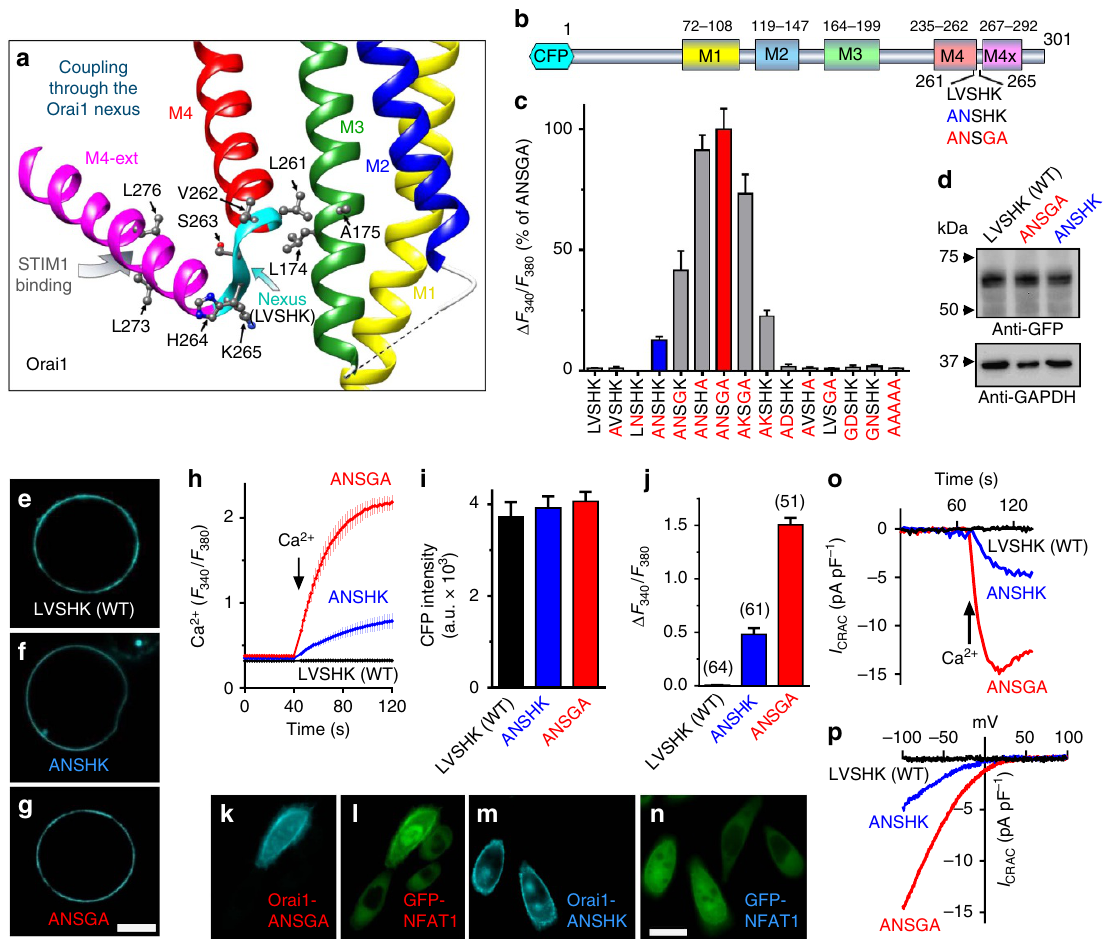
Figure 1 | The Orai1-ANSGA nexus mutation mediates constitutive store-independent CRAC channel activity. ( a ) Schematic representation of the human Orai1 nexus (LVSHK; 261–265) and surrounding helices (Supplementary Fig. 1). ( b ) Diagram of hOrai1 transmembrane -helices and nexus mutations. ( c ) Peak constitutive Ca 2 þ entry mediated by CFP-Orai1 nexus mutations expressed in HEK cells, compared with the effect of ANSGA (100%). ( d ) Expression of CFP-Orai1-LVSHK (WT), CFP-Orai1-ANSGA and CFP-Orai1-ANSHK detected with GFP antibody, compared with GAPDH expression. ( e – g ) PM localization of CFP-Orai1-LVSHK (WT), CFP-Orai1-ANSHK and CFP-Orai1-ANSGA in HEK cells. Scale bar, 5 m m ( h ) Fura-2 ratiometric constitutive Ca 2 þ responses in HEK cells expressing CFP-Orai1-LVSHK (WT), CFP-Orai1-ANSHK or CFP-Orai1-ANSGA. ( i ) CFP fluorescence intensity (a.u.) of cells in h . ( j ) Average peak Ca 2 þ entry responses from three independent experiments. ( k – n ) Nuclear translocation of NFAT-GFP ( l , n ) induced by CFP-Orai1- ANSGA ( k , l ) or CFP-Orai1-ANSHK ( m , n ) transfected into Hela cells stably expressing NFAT-GFP. Note, all cells express NFAT-GFP, but only one cell ( k , l ) or two cells ( m , n ) are transfected with Orai1 nexus mutants, respectively. Scale bar, 10 m m ( o ) Whole-cell I CRAC in store-replete HEK cells transfected